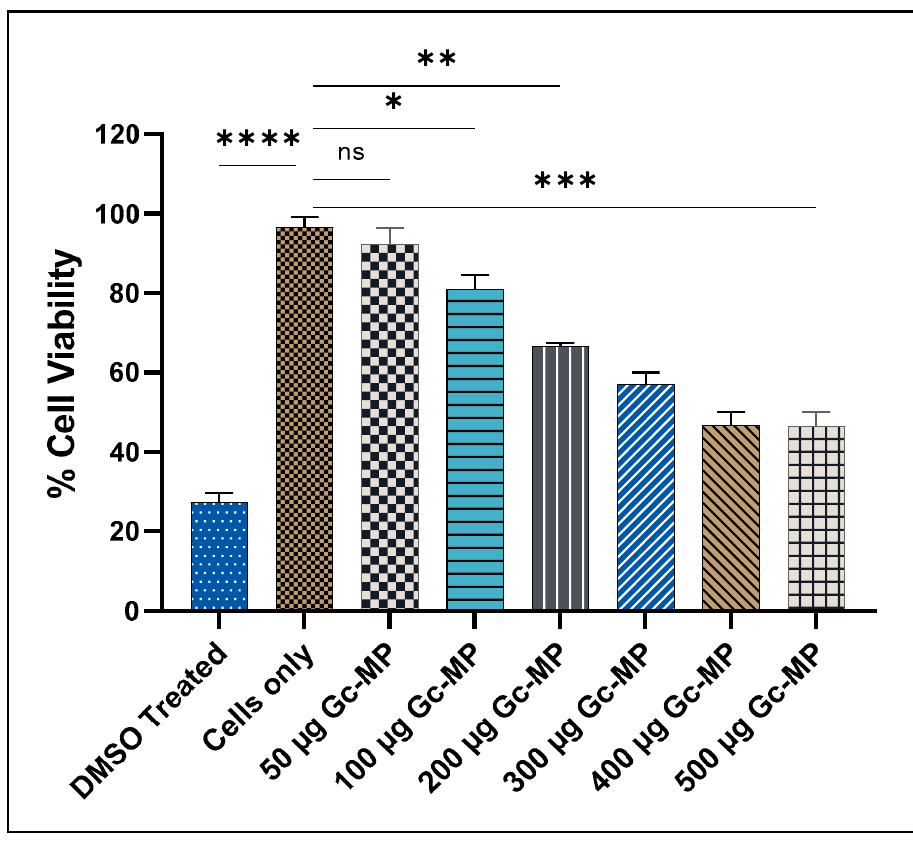
Figure 3. Dendritic cell (DC 2.4) viability after exposure to different amounts of gonococci vaccine microparticles measured using MTT assay. DC 2.4 cells (2.5 × 10 4 cells/well) were exposed to increasing doses of Gc-MP (50 to 500 µg/well) or DMSO (50 µL) and incubated at 37 °C for 48 h. All the experiments were repeated as three independent experiments with three replicates in each experiment. Data are expressed as mean ± SD, One-way ANOVA- Brown-Forsythe and Welch ANOVA test. ns, no significant, * p < 0.05 significant, ** p < 0.01 very significant, *** p < 0.05 extremely significant, **** p < 0.001 extremely significant. Dimethyl sulfoxide (DMSO); Cells only: Unstimulated DC 2.4 were used as the